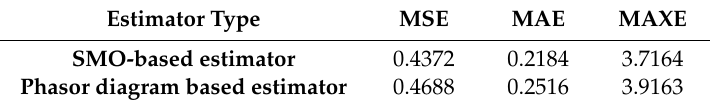
Table 3. Performance indices of the SMO-based estimator and the phasor diagram based estimator during dynamic disturbances of reactive power for generator operating point P = 0.89, Q = 0.